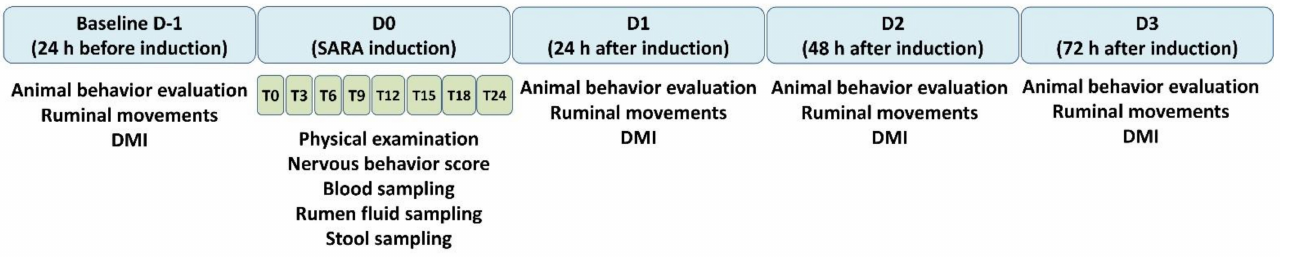
Figure 1. Experimental design, evaluated moments, and sampling